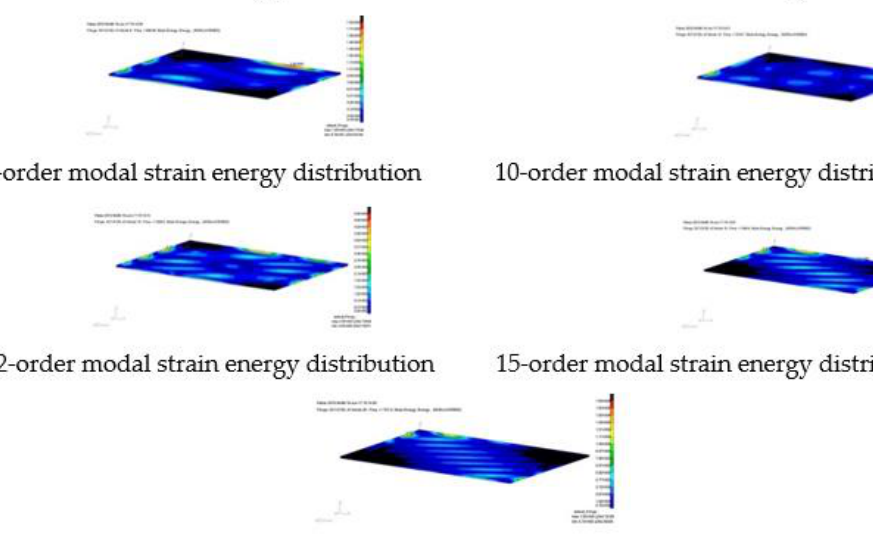
Figure 5. The equal proportion linear summation strain energy of the first 20 modes of the composite plate.